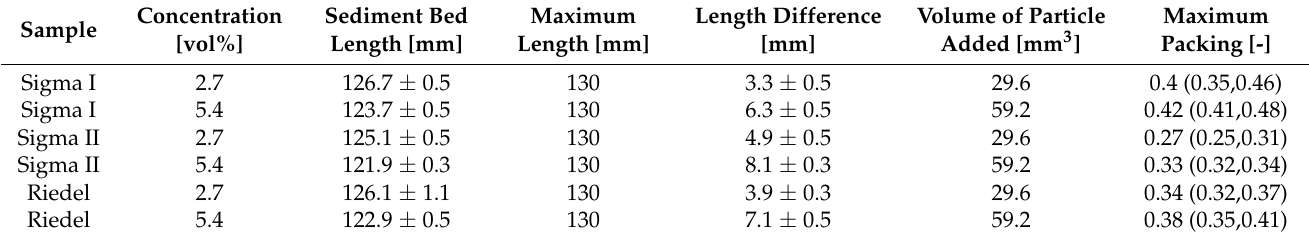
Figure 6. Transmission profiles obtained during centrifugation of a kaolinite sample: ( a ) Sigma I, ( b ) Sigma II and ( c ) Riedel at 14 wt% at 4000 rpm for duration of roughly 30 s (corresponding to a centrifugal acceleration 2017 g, based on middle point of 115 mm). Volume of suspension added into the cells is 1.1 mL. Position of illuminated cell varies between 103–130 nm; the low transmission at the end of the cell demonstrates that particles are accumulating there. Table 1. Based on the results of Figure 6, an estimation of the maximum packing using LUMisizer profiles at a 4000-rpm centrifugation rotation speed is presented in the final column for all three different kaolinite